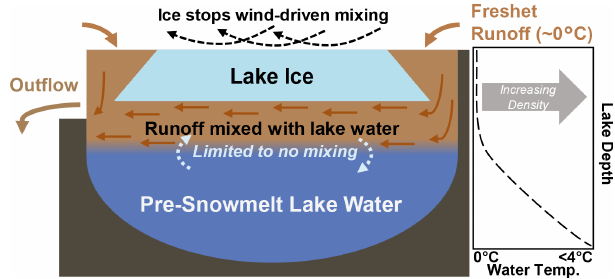
Figure 1. A conceptual cross section of an open-drainage lake when freshet has begun. Freshet initially flows into the lake at the edge where lake ice has melted. A layer of snowmelt runoff mixed with lake water then remains buoyant on top of the warmer lake water before flowing through the outlet (i.e., “snowmelt bypass”). Limited mixing occurs due to density differences between runoff and deeper lake water and the lack of wind-driven mixing due to the presence of lake